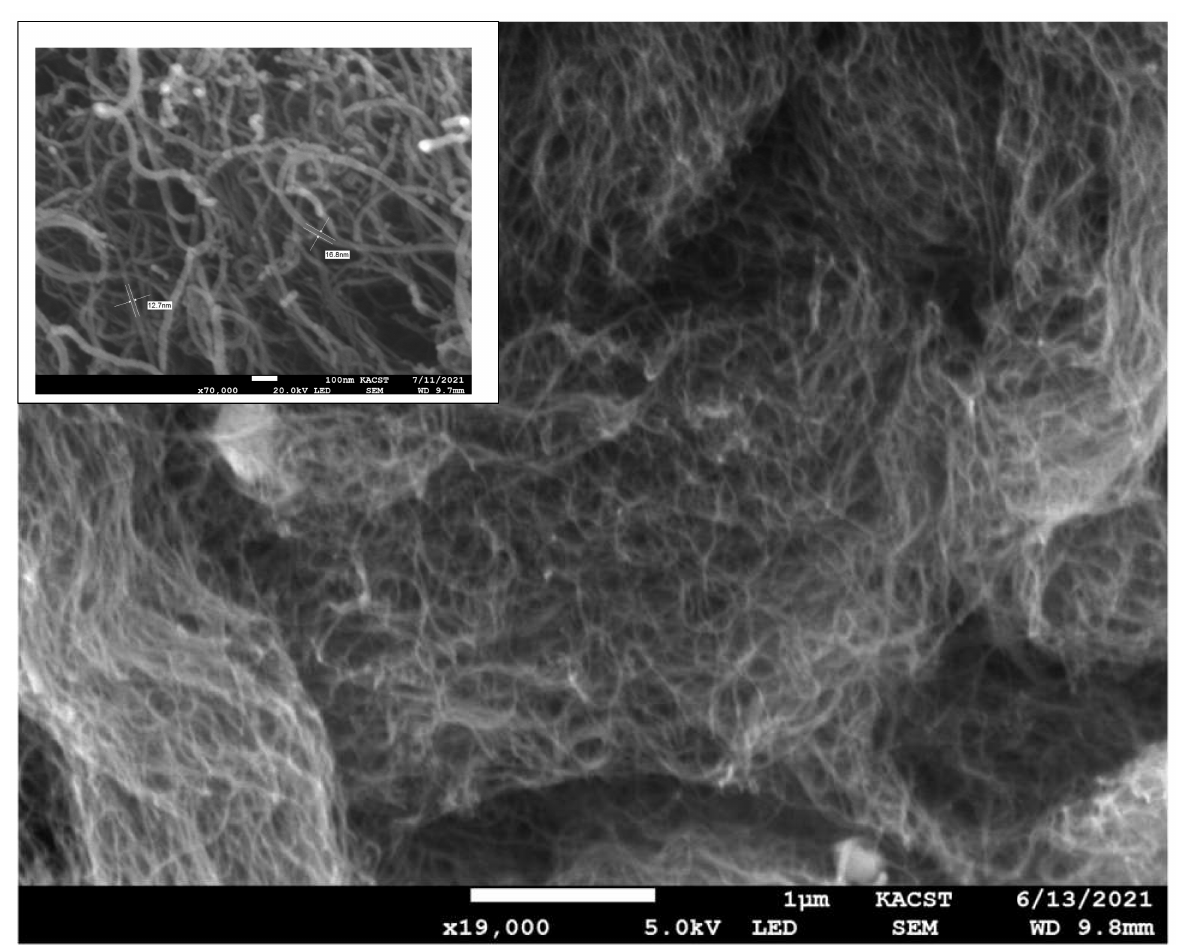
Figure 2. SEM micrograph of MWCNTs used in preparing composites. The scale bar indicates 1 µ m. The inset image of MWCNTs shows that the average diameter is not less than 12